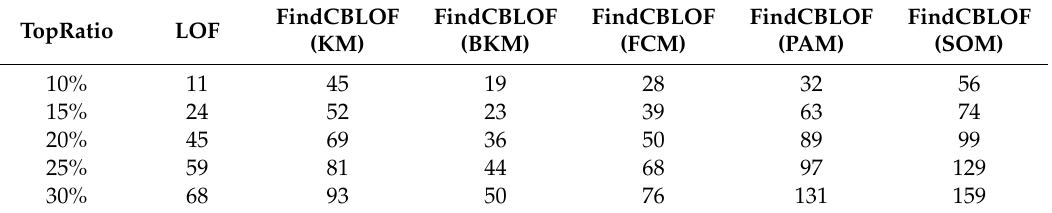
Table 7. Number of Detected Outliers for the Breast Cancer Dataset (FindCBLOF).